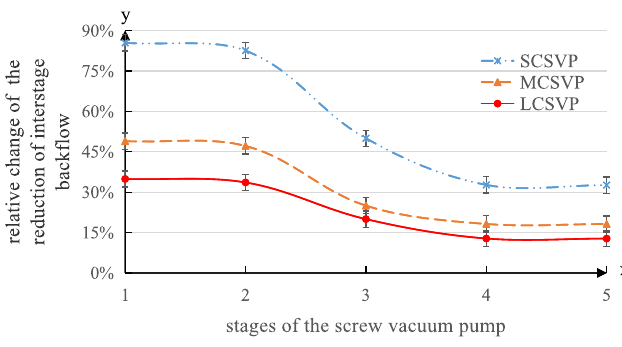
Fig. 18. The decline curves of interstage back fl ow at different clearances lengths.